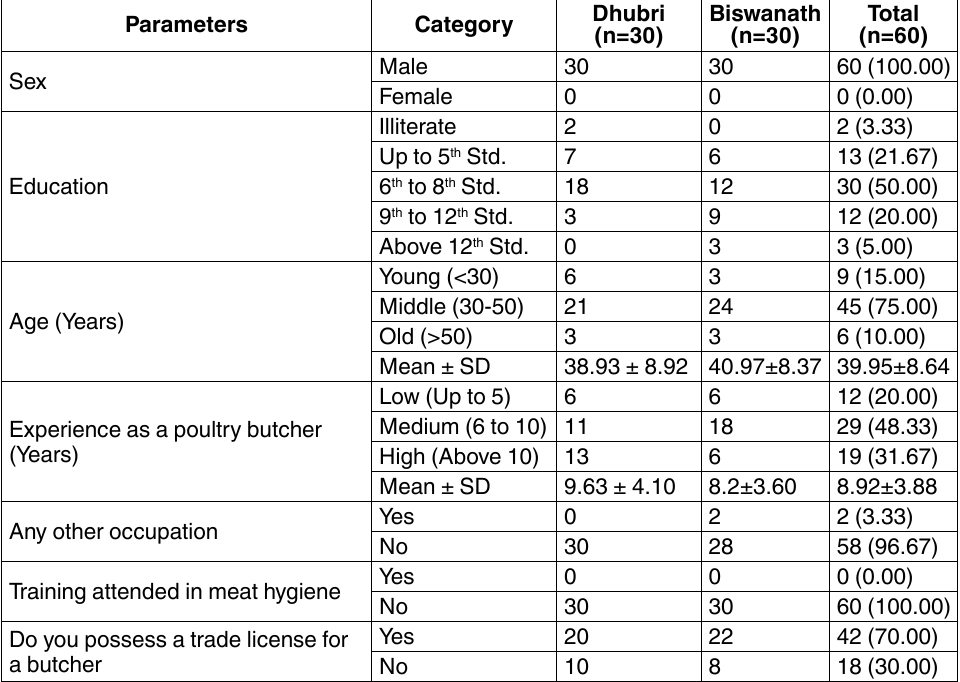
table 1. Distribution of respondents based on their socio-economic profile